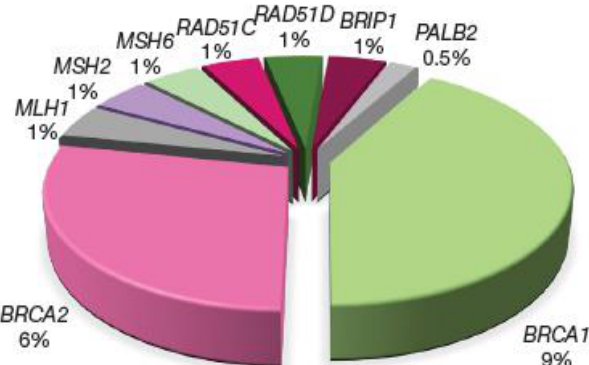
Figure 2. Distribution of germline pathogenic variants (PVs) identified in unselected epithelial ovarian cancer (EOC) patients. Among 21.5% of those PVs, 15% represent alterations to BRCA1/2 genes and 3.5% of genetic aberrations in other genes compromise the homologous recombination (HR) pathway whilst 3% are PV genes involved in the DNA mismatch repair (MMR) pathway.